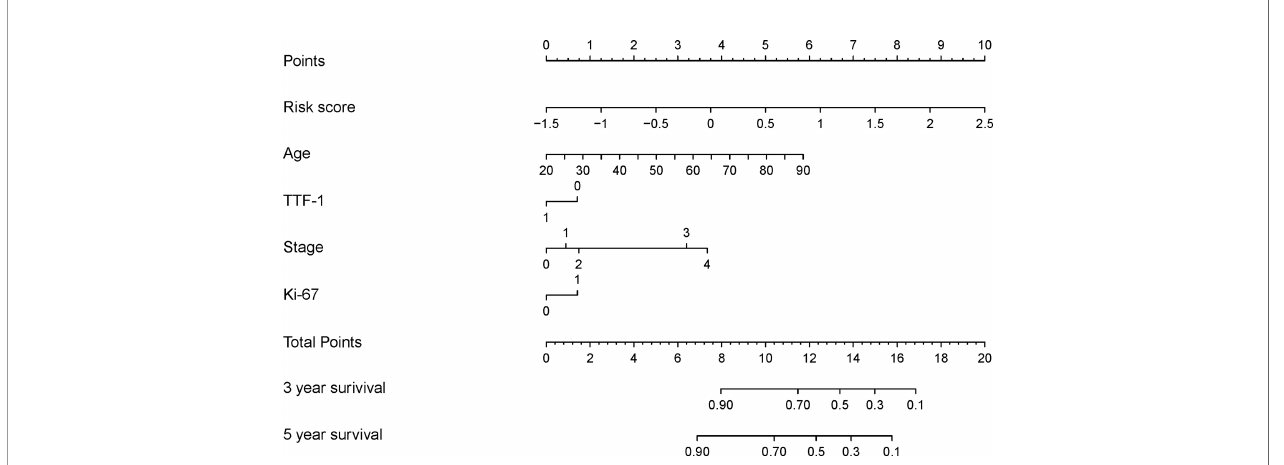
FIGURE 4 | Development of the DeepSurv nomogram by integrating the risk score combined with the clinicopathological factors in the training